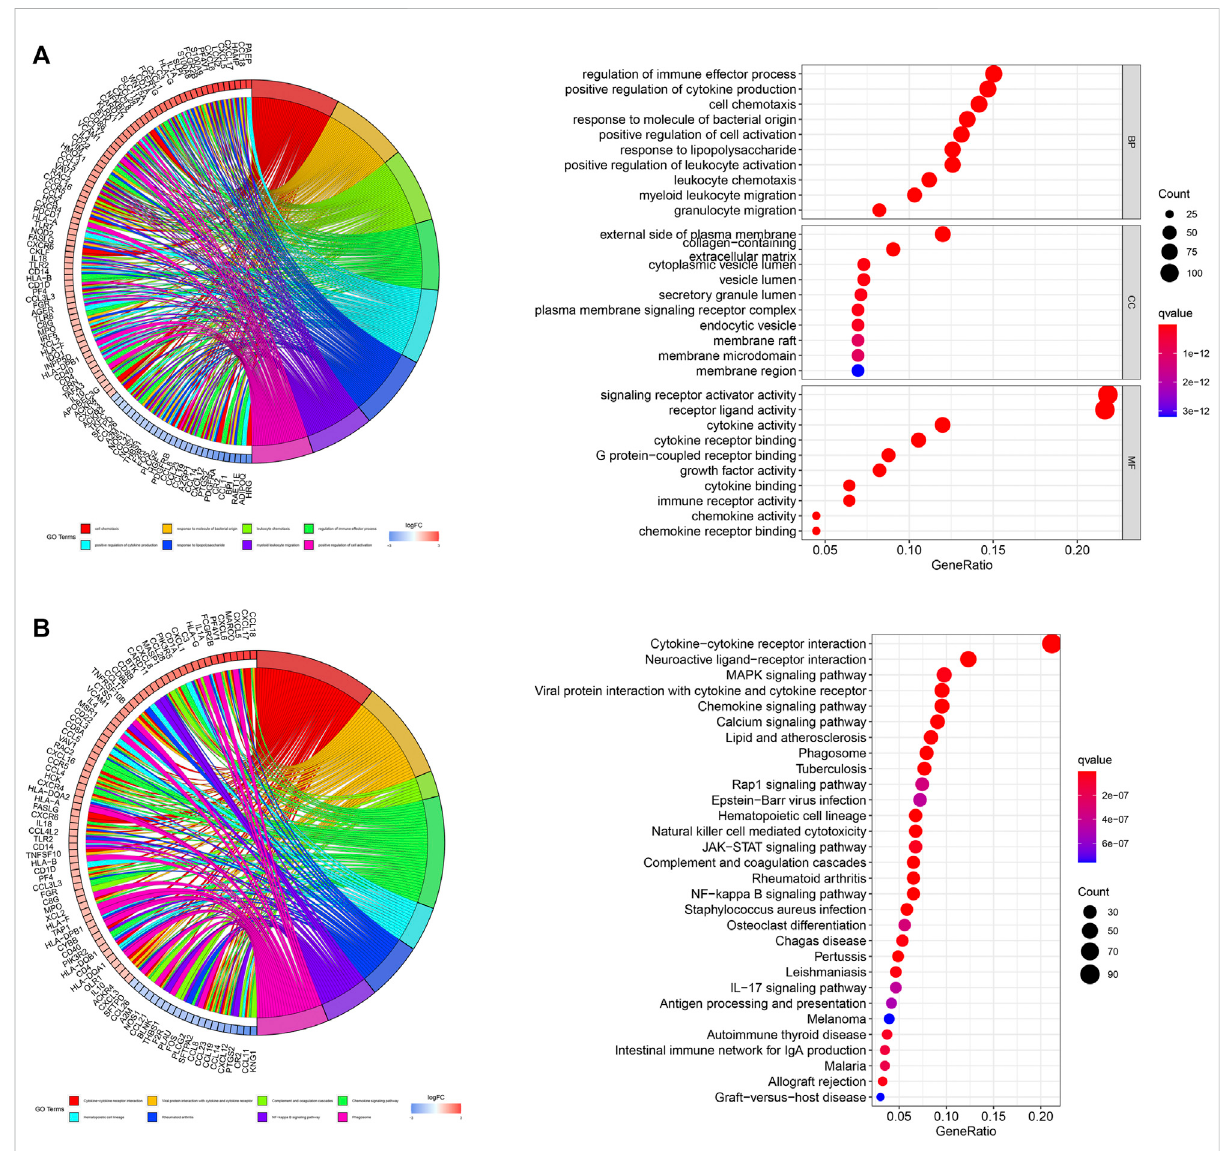
FIGURE 2 Functional enrichment analysis of differentially expressed IRGs. (A) Chord plot and bar graph of GO enrichment analysis. (B) Chord plot and bar graphofthetop30KEGGsignalingpathways.IRGs,immune-relatedgenes;BP,biologicalprocess;CC,cellularcomponent;MF,molecularfunction; KEGG, Kyoto encyclopedia of genes and